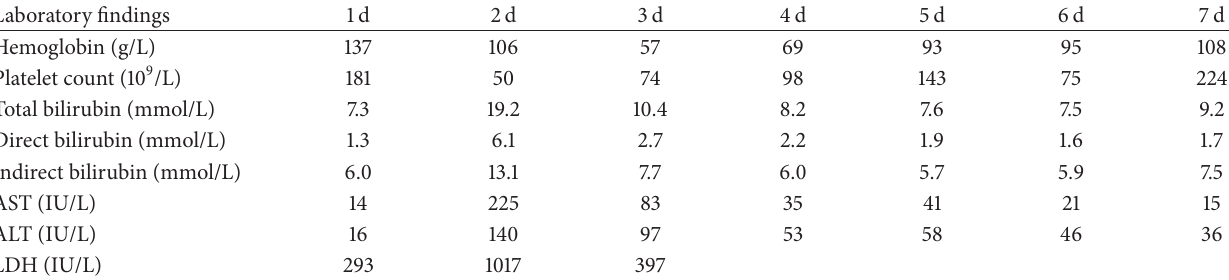
Table 1: Laboratory findings postpartum in case 1. Time postpartum.